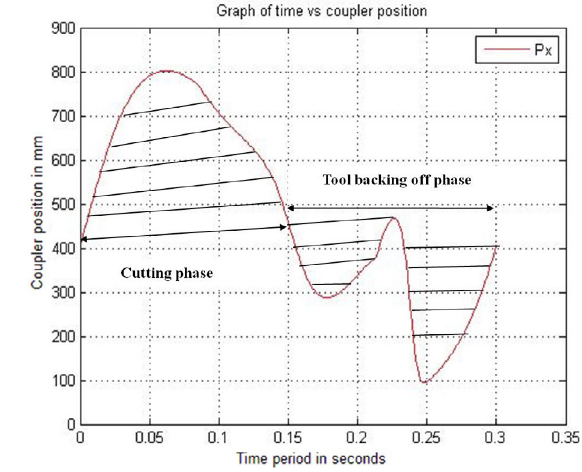
Figure 5: Time period (s) versus coupler tool trajectory (mm) for one complete cycle Figure 3: Derived and desired coupler position (mm) Velocity and acceleration analysis of the designed mechanism is performed in MATLAB. The plot of time vs. velocity and acceleration of the cutting tool, while the tractor is moving in the forward direction, is shown in Figure 6 .